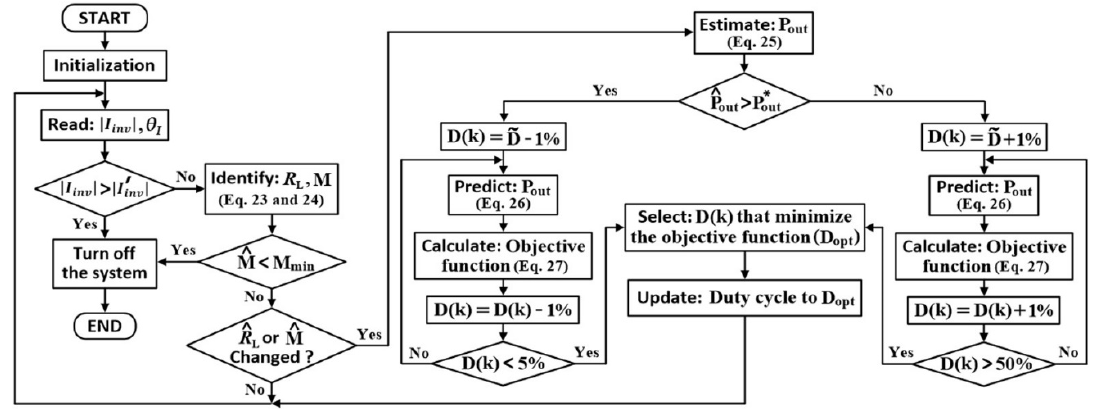
Figure 7. Program flowchart of the microcontroller.